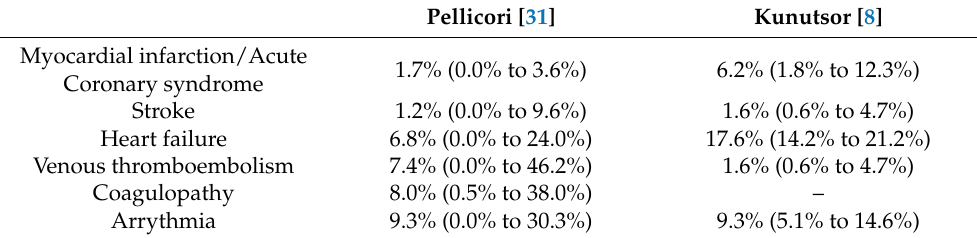
Table 2. Incidence of cardiovascular events in patients with